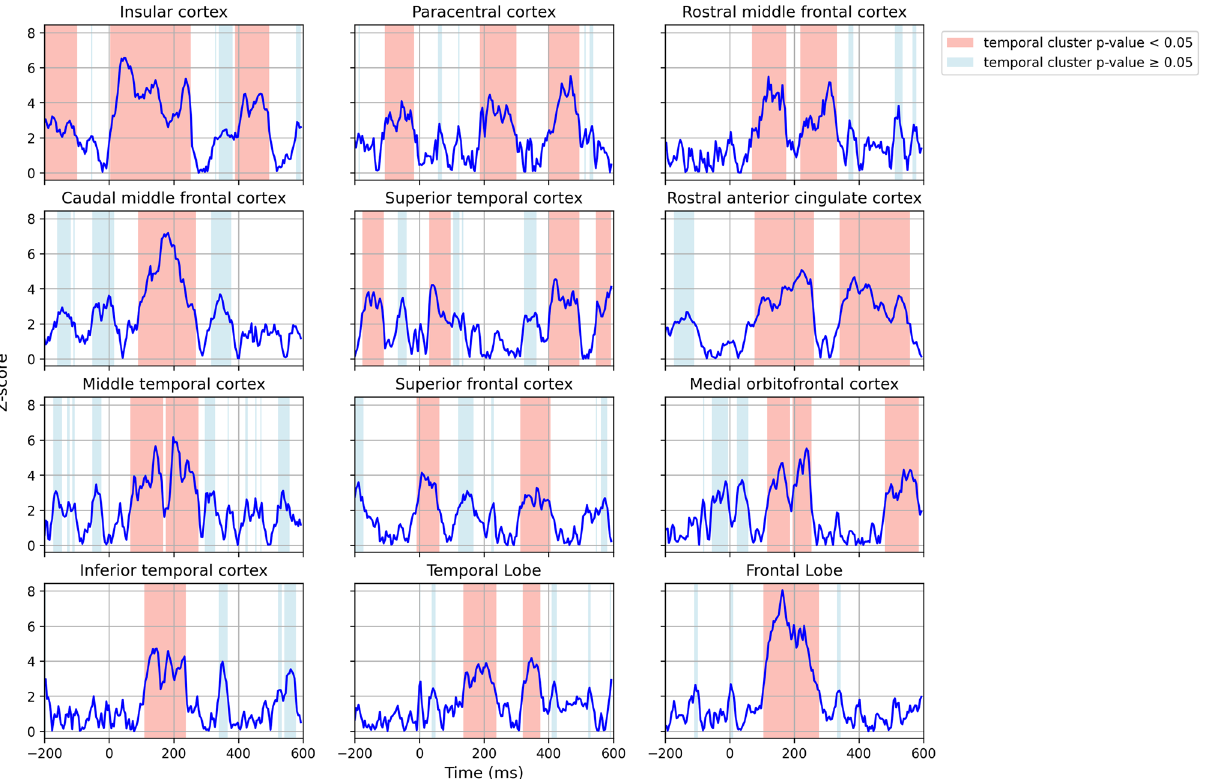
Figure 3. A cluster-based permutation test for each sub-region within a single session (Subject 3, Session 2). The blue line represents the z-score at each time point. The consecutive temporal clusters with z-score > 1.96 are highlighted. The temporal clusters showing significant ( p < 0.05 ) difference between the iEEG windows sampled around note onsets and the reference windows are highlighted in red; the non-significant clusters are highlighted in blue.